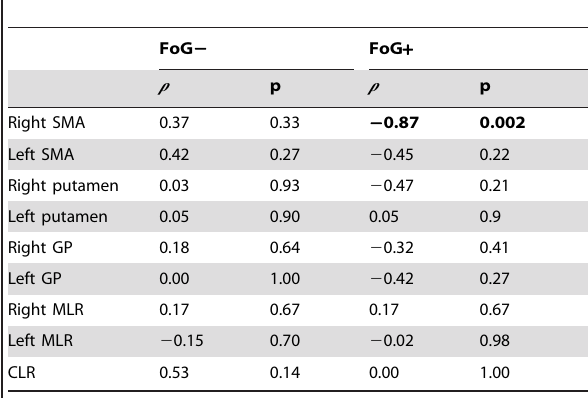
Table 5. Correlation (Spearman’s Rho and p-value) between imagined walking beta weights and actual overground walking speed.